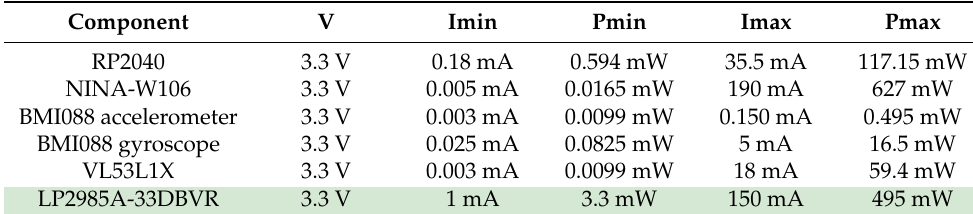
Table 5. Component consumption and power supplied by the LP2985A-33DBVR regulator.